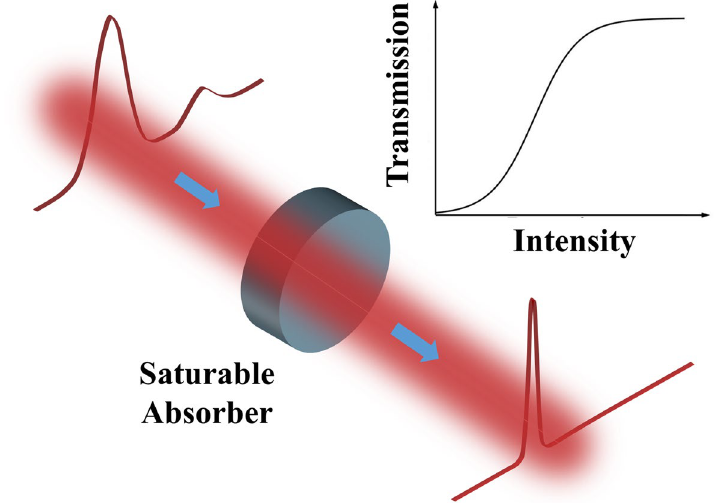
Fig. 1 Principle of SA in mode-locked lasers. The transmission of a SA is intensity dependent: CW laser and pulses with low intensity would experience large loss, while pulses with high intensity would enjoy high